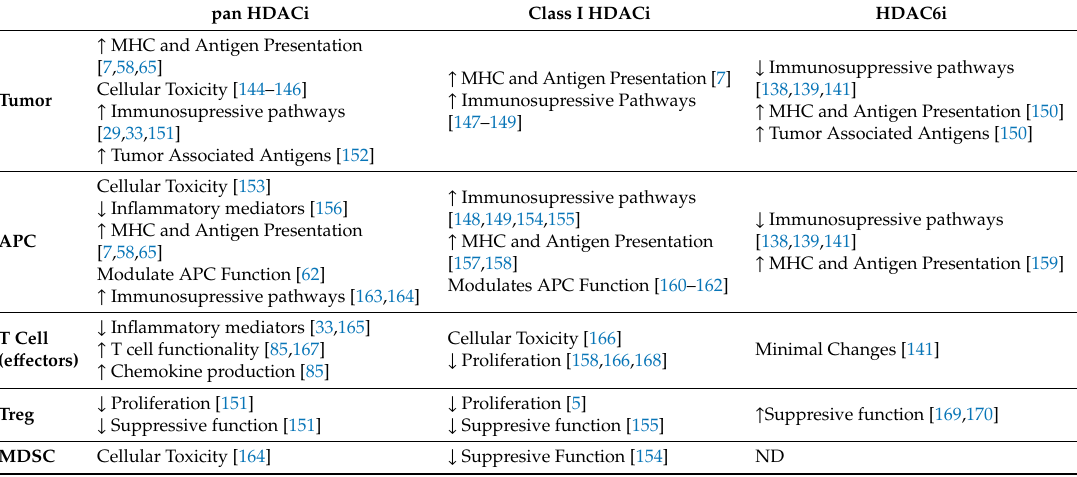
Table 5. Comparison of pan-HDACi and class 1 HDACi to a selective HDACi in the context of immune